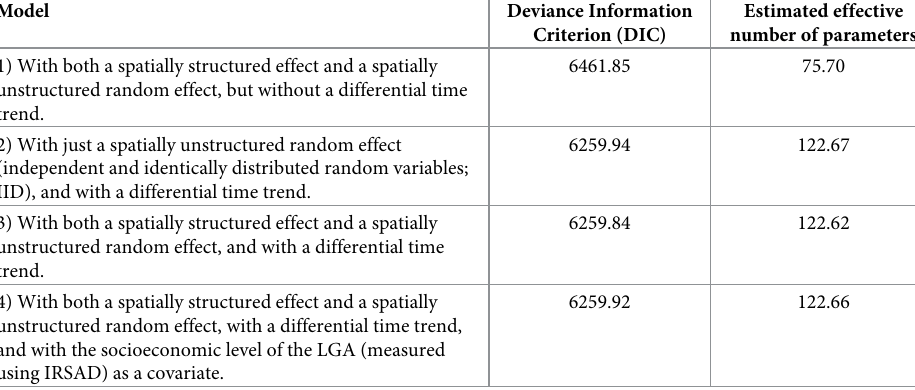
Table 2. Model fits for the four models (Models